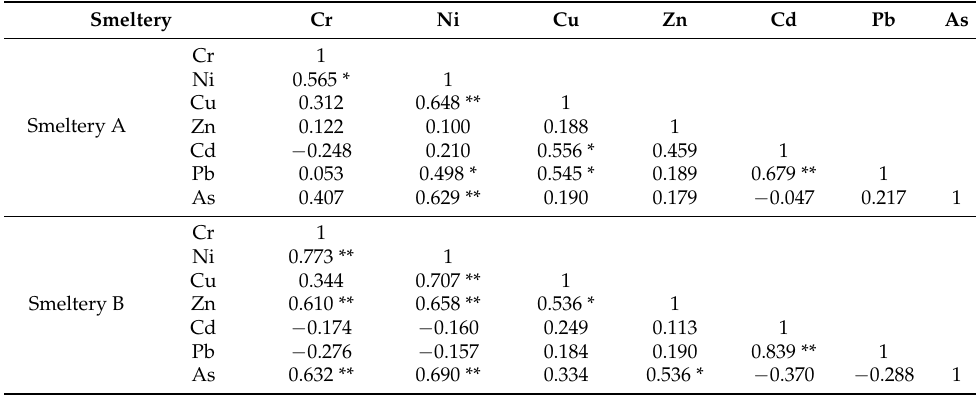
Table 3. Correlation analysis of heavy metals in soil near Smeltery A and B.